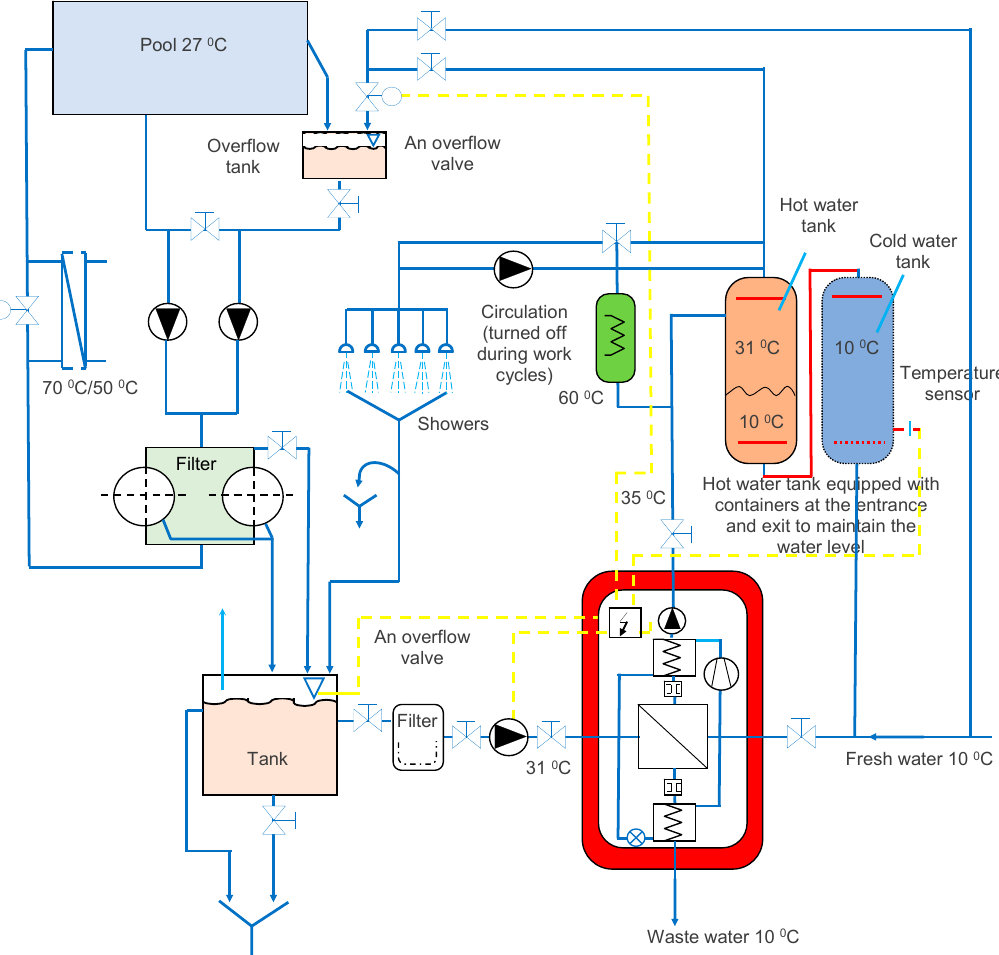
Figure 1. Operation of the heat recovery installation.